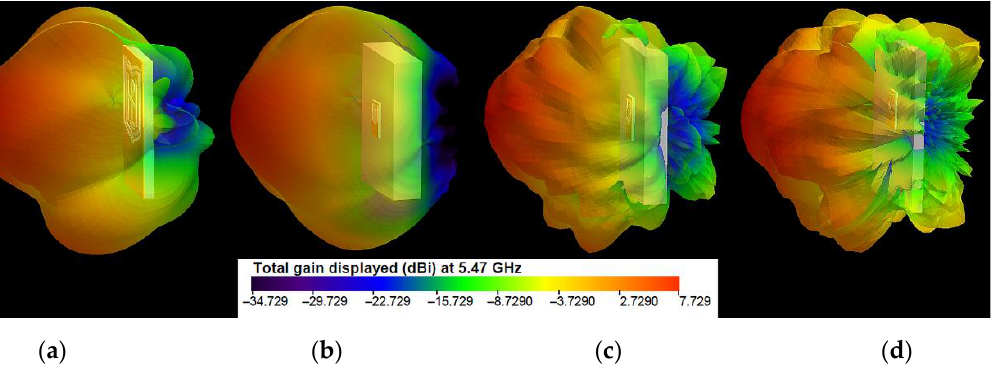
Figure 6. Simulated 3D radiation patterns of the antenna at 5.47 GHz: ( a ) in free space; ( b ) on the human-body model; ( c ) on the notebook model; ( d ) on the laptop model.